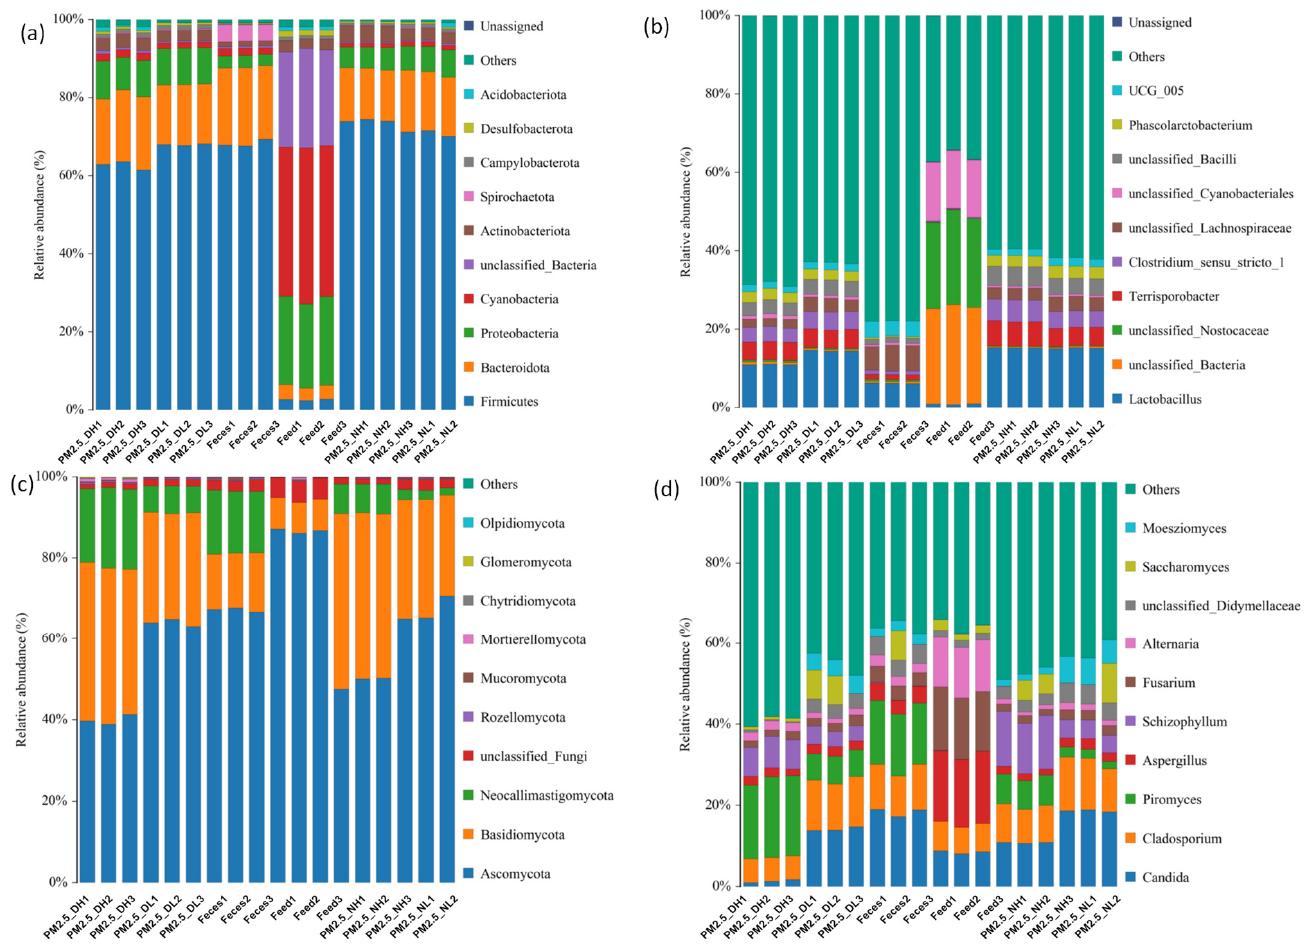
Figure 1. Distribution of bacteria ( a , b ) and fungi ( c , d ) in samples; ( a , c ) indicate composition at the phylum level and ( b , d ) indicate composition at the genus level.